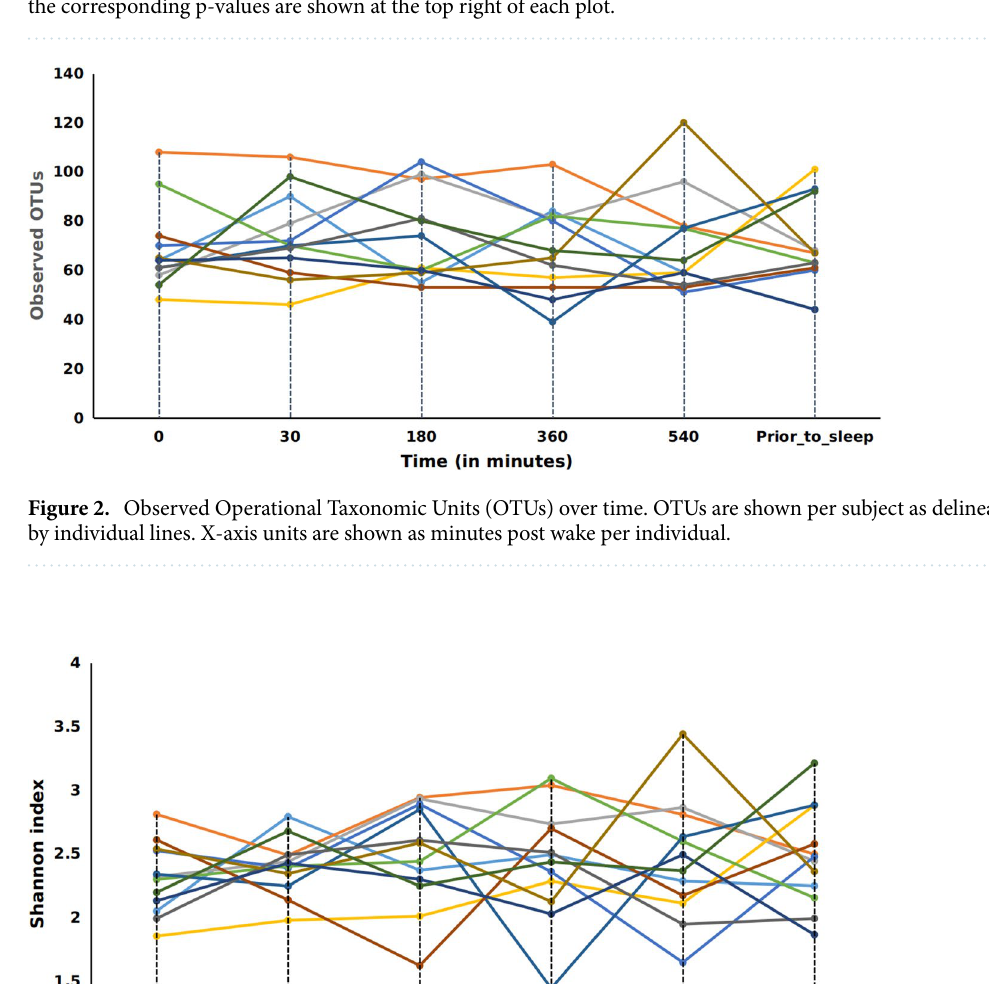
Figure 1. Alpha diversity analysis of oral microbiome obtained from longitudinally collected saliva samples from 12 individuals. Operational taxonomic units ( left panel ), Chao1 ( middle panel ), and Shannon Diversity Index analysis ( right panel ). For each of the metric (Observed OTUs, Chao1 and Shannon Index), Mann– Whitney test was used to determine if the values differ across the time-points (represented by each boxplot) and the corresponding p-values are shown at the top right of each plot.